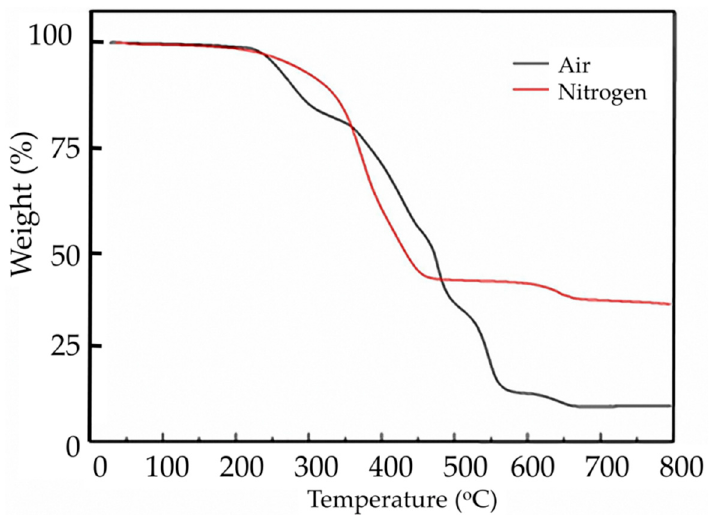
Figure 4. TGA curves of the crumb rubber under various ambient conditions.